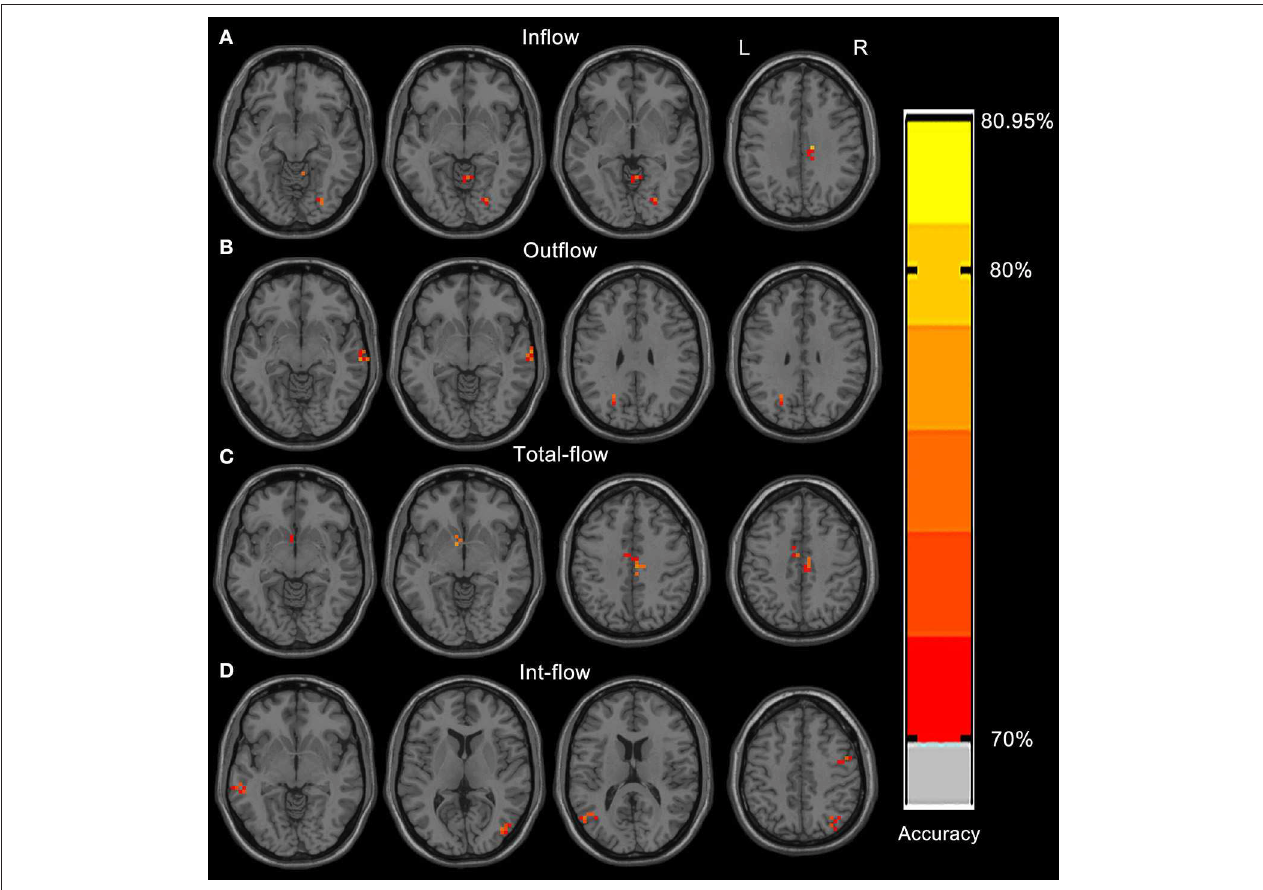
FIGURE 2 | Resulting spatial maps of accuracy for discriminating between IEDs and non-IEDs substates for each of the four GCD metrics. These clusters were identified by setting the threshold of accuracy higher than 70%. Resulting spatial brain areas of accuracy for discriminating between IEDs and non-IEDs substates for Inflow (A) , outflow (B) , total-flow (C) , and int-flow (D) connectivity.